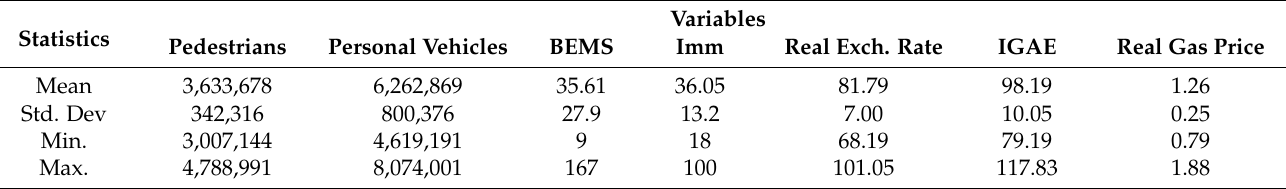
Table 2. Descriptive statistics of the main variables